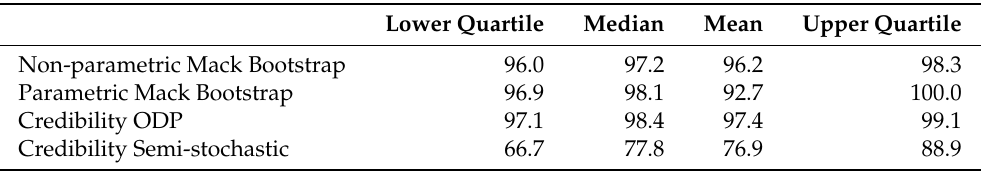
Table 6. Multiyear equivalent of the one-year 99.5%–VaR stemming from the four estimation method (in